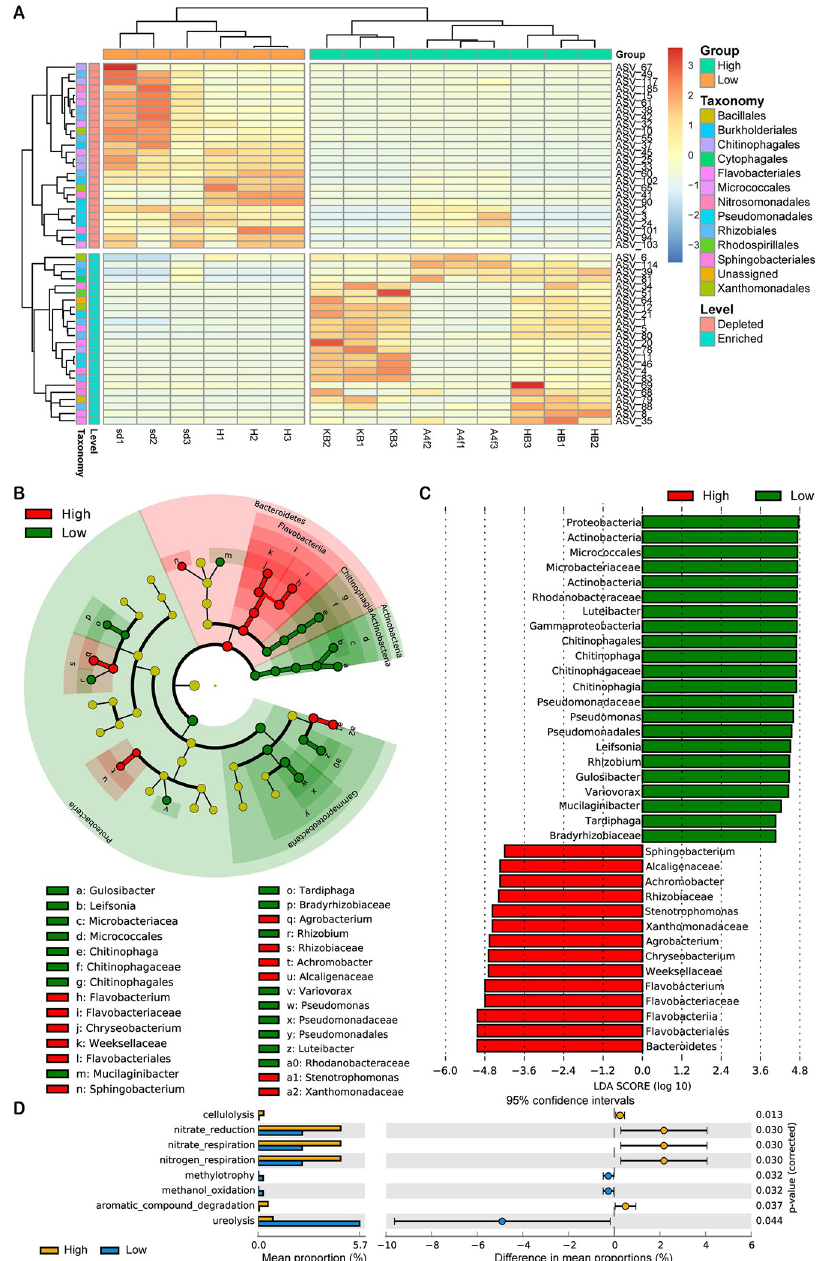
Fig 6. Taxonomic and functional characteristics of differential bacteria in ‘high’ and ‘low’ germination rate groups. (A) Relative abundance of the corresponding ASVs enriched in ‘high’ and ‘low’ germination rate groups (Wilcoxon rank sum test, FDR adjusted P < 0.05). (B) Cladograms generated by LEfSe indicating differences in the bacterial taxa between ‘high’ and ‘low’ germination groups. Red bars indicate taxa enriched in ‘high’ germination rate group, green bars indicate taxa enriched in ‘low’ germination group. (C) LDA scores for the bacterial taxa differentially abundant in ‘high’ and ‘low’ groups. Red bars indicate taxa enriched in high germination rate group, and green bars indicate taxa in low germination group. (D) Metabolic and ecological functions of ASVs enriched in ‘high’ and ‘low’ groups based on FAPROTAX (Welch’s t-test, P < 0.05).